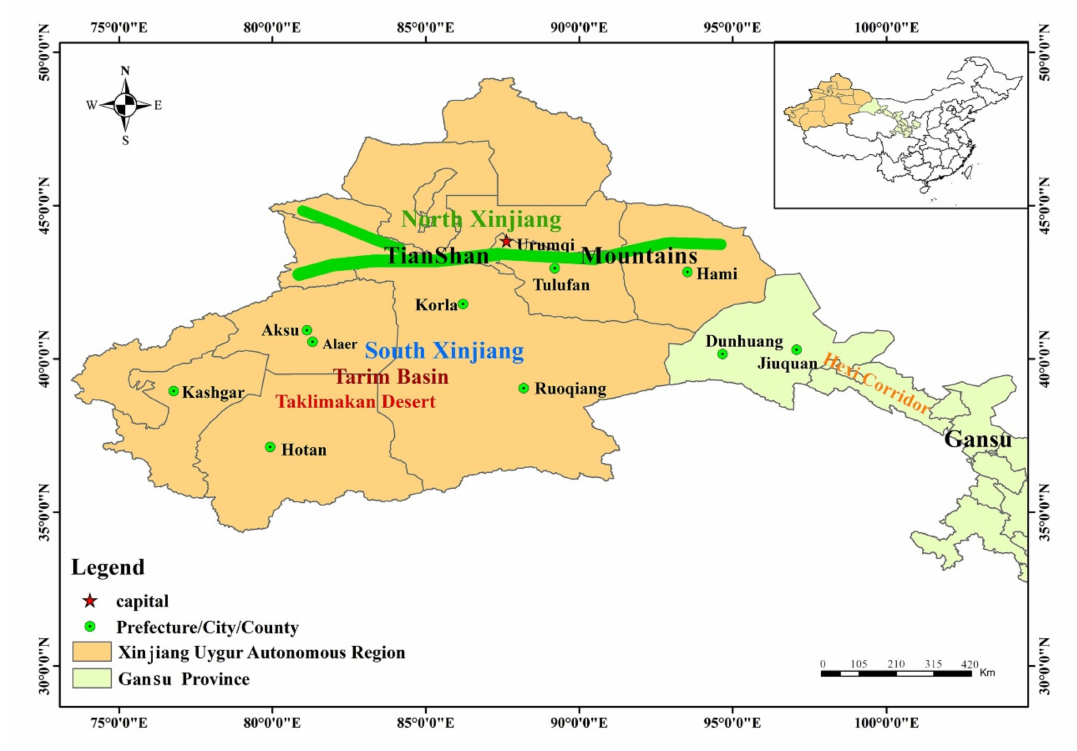
Figure 2. Main geographical locations and features of occurrence